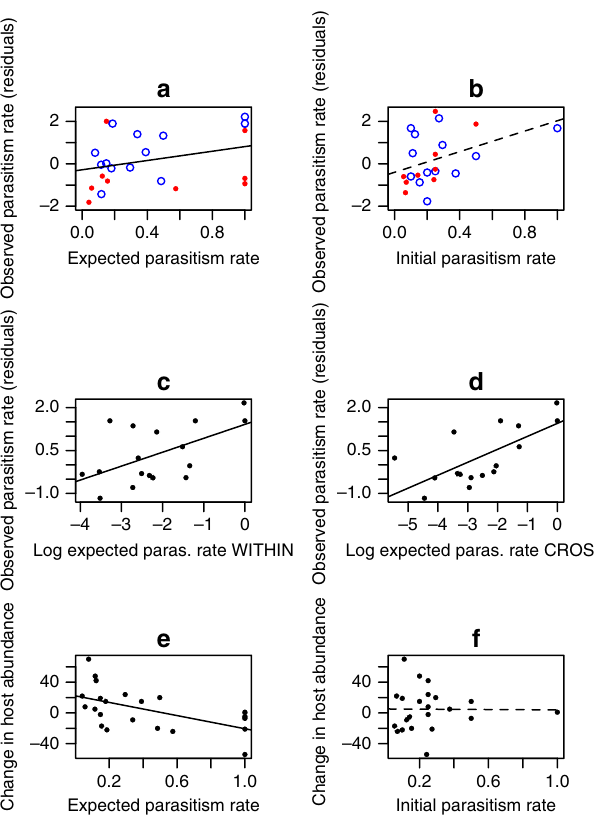
Figure 5 | Predictions of parasitism rate and change in host abundance. ( a ) Expected parasitism rate predicted observed parasitism rate (GLMM; z ¼ 2.7, P ¼ 0.007, R 2 (GLMM(m) ¼ 0.16), whereas ( b ) initial parasitism rate did not predict observed parasitism rate (GLMM; z ¼ 1.1, P ¼ 0.266). Observed parasitism rate was also significantly predicted by expected parasitism rates calculated with only ( c ) data from within the same forest as the focal host (GLMM; z ¼ 2.8, P ¼ 0.005, R 2 GLMM(m) ¼ 0.20), or ( d ) data from the forest adjacent to the focal host’s habitat (GLMM; z ¼ 2.1, P ¼ 0.040, R 2 (GLMM(m) ¼ 0.14). ( e ) Expected parasitism rate also significantly predicted change in host abundance (linear model; z -value ¼ (cid:2) 3.0, P ¼ 0.007, R 2 ¼ 0.31), but ( f ) initial parasitism rate did not predict change in host abundance (linear model; initial parasitism rate was removed as a predictor during model selection). In a – d , residuals of the best model excluding the predictor on the x axis are plotted, and raw data are plotted in e and f . Residuals are deviations of the logit-linked data from the best model, and show the unexplained variation in the data remaining once variation due to the other fixed and random effects in the model have been accounted for. That is, they show the variation in the data that we are hoping to explain with the predictor on the x axis. Each point represents a species within a site that was collected and successfully reared at both time steps, and was parasitized in the first time step (see equation (3); Fig. 1i). In a and b closed circles (red) represent hosts in plantation forest and open circles (blue) represent hosts in native forest, though only one fitted line is presented because there was no significant habitat A (cid:3) expected parasitism rate interaction (in a the interaction term was removed during model selection; ( b ) interaction z ¼ 1.9, P ¼ 0.060). In all panels, n ¼ 8 pairs of treatment and control sites as replicates. binary information on the presence/absence of species links, some qualitative predictions could still likely be made. Expected parasitism based on a binary regional food web was a marginally non-significant predictor of observed parasitism ( z ¼ 1.9, P ¼ 0.056, with a partial regression coefficient of 1.9 (s.e. ¼ 0.99) for binary data (Supplementary Table 8a), compared with 2.3 NATURE COMMUNICATIONS|7:12644|DOI: